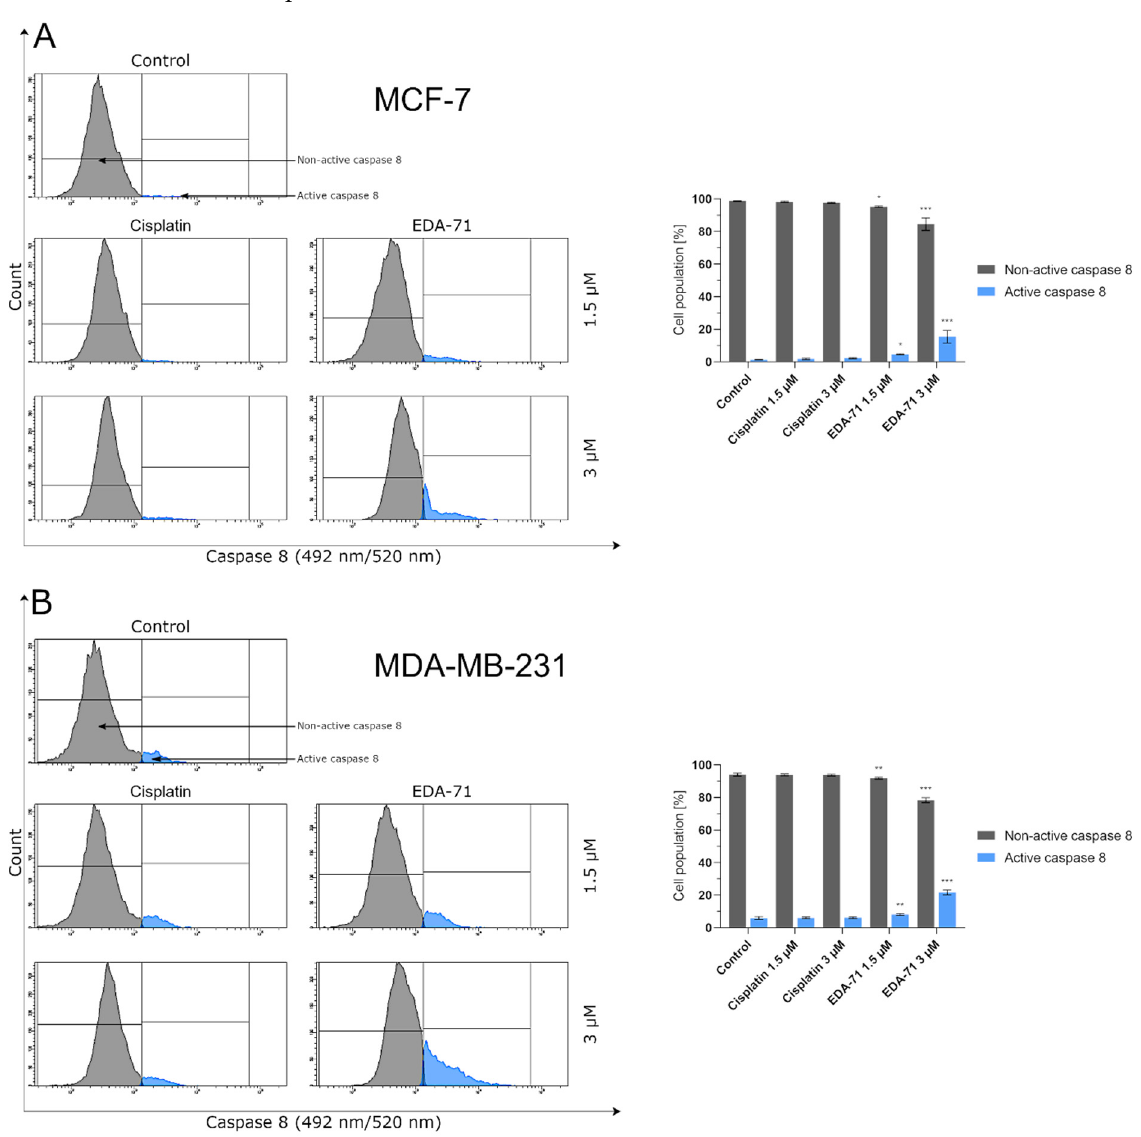
Figure 5. Cytometric analysis of caspase 8 activity in MCF-7 ( A ) and MDA-MB-231 ( B ) breast cancer cells after 24 h incubation with EDA-71 and cisplatin (1.5 and 3 µM). Results are presented as mean values ± SD obtained from three independent experiments ( n = 3) conducted in triplicate. Statistical differences between the experimental (treated cells) and control (untreated cells) groups were determined using one-way ANOVA followed by Dunnett’s test. * p < 0.05 vs. control group, ** p < 0.01 vs. control group, *** p < 0.001 vs. control group.